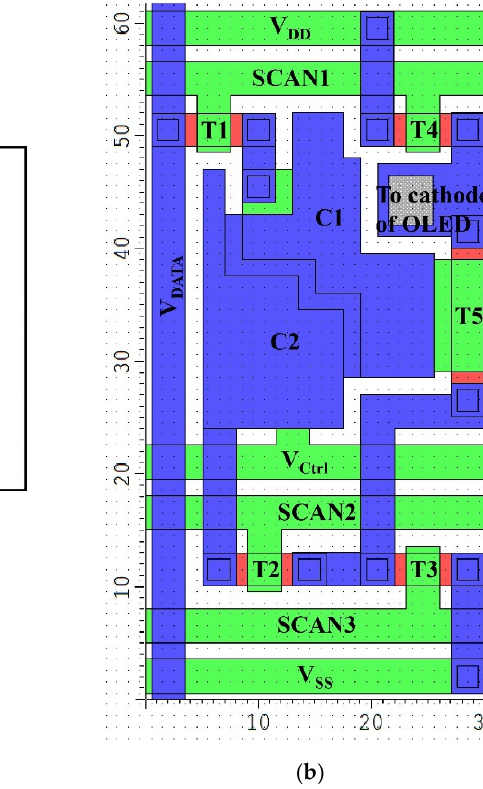
Figure 6. ( a ) OLED currents of different V DATA when V TH_OLED shifts from 0 to 0.5 V. ( b ) OLED currents of different data voltages when V DD drops by 0.5 V.